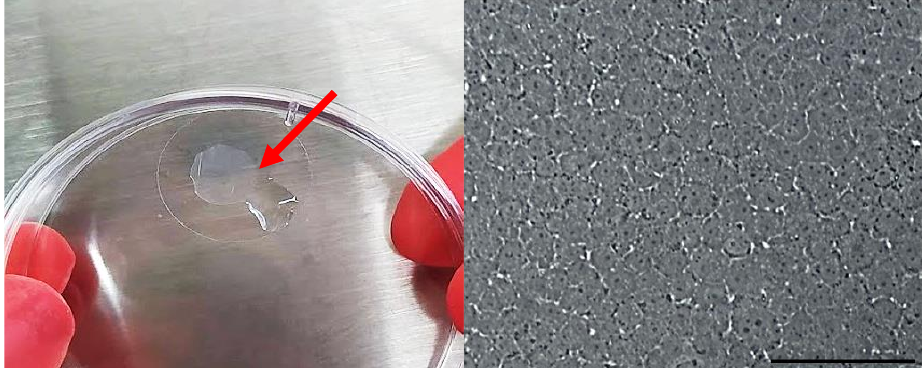
Figure 7. Engineered corneal endothelium (arrow): construct made of CVM and CECs ( left ). Micro- scopic view of CECs cultured over 2X CVM ( right ). Scale bar = 100 μ m.